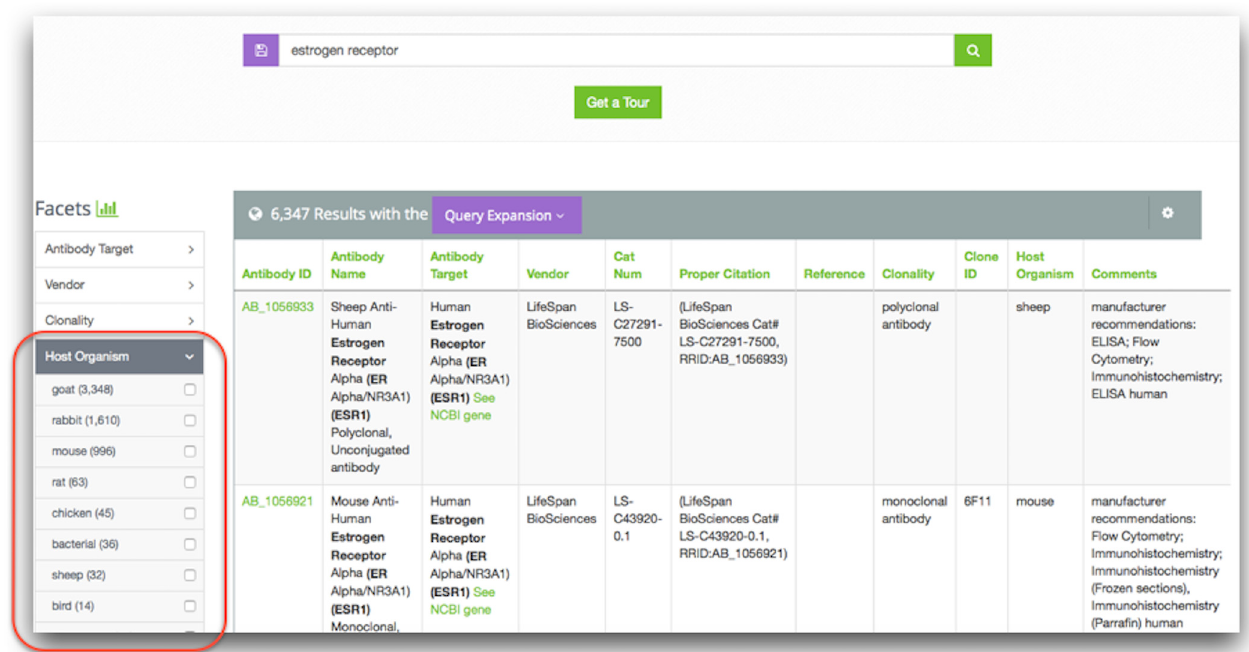
Fig 5. Example of faceted data in dkNET. Data columns that contain repeated values are selected by the data curators to be faceted. This is one type of ‘ filter ’ to help users narrow search results.